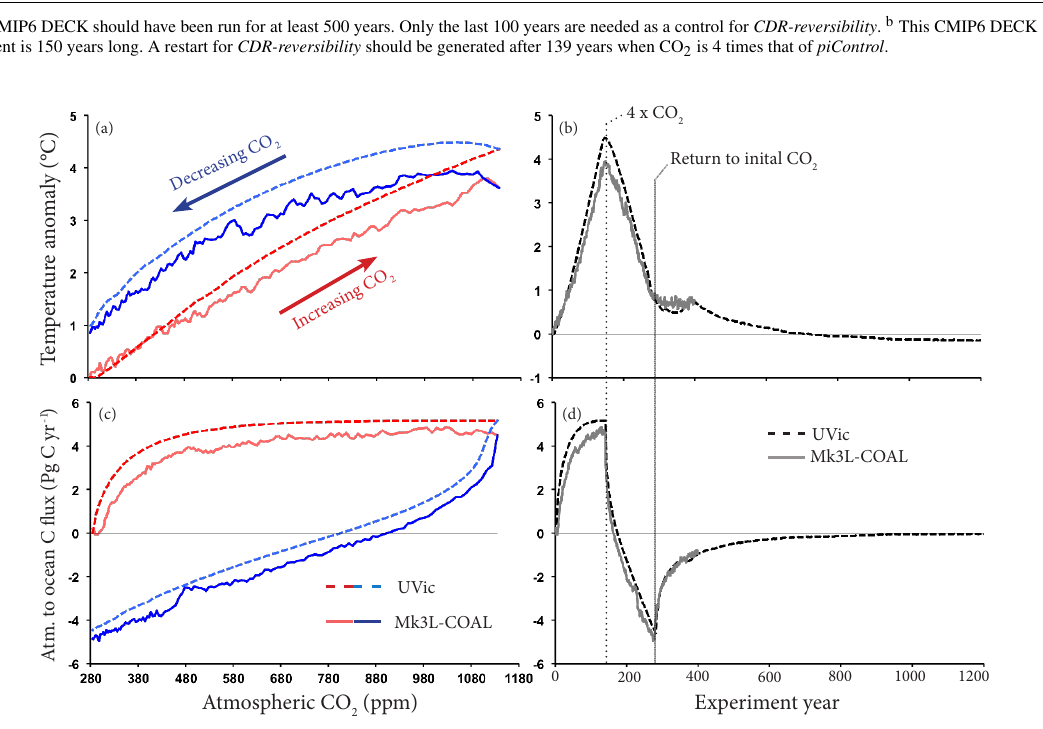
Figure 2. Exemplary climate and carbon cycle reversibility experiment ( CDR-reversibility ) results with the Mk3L-COAL Earth system model and the University of Victoria (UVic) Earth system model of intermediate complexity (models are described in Appendix D). The left panels show annual global mean (a) temperature anomalies ( ◦ C; relative to pre-industrial temperatures) and (c) the atmosphere to ocean carbon fluxes (PgCyr − 1 ) versus the atmospheric CO 2 (ppm) during the first 280 years of the experiment (i.e., when CO 2 is increasing and decreasing). The right panels show the same (b) temperature anomalies and (d) the atmosphere to ocean carbon fluxes versus time. Note that the Mk3L-COAL simulation was only 400 years